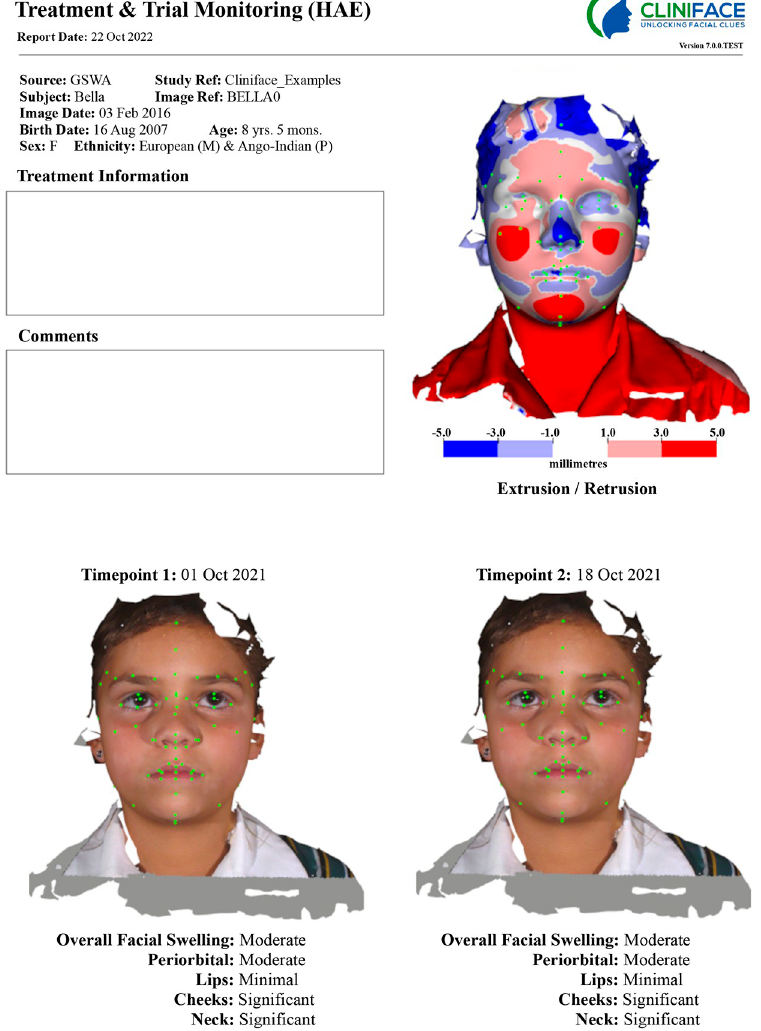
Fig 3. Mock-up example of Cliniface 3D facial ‘Hereditary Angioedema treatment and monitoring report’ Parental consent was obtained from the parent (Gareth Baynam) of the child whose image is appearing in Fig 3 who is also the corresponding